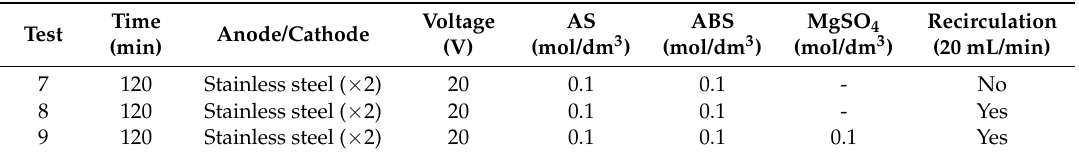
Table 4. Summary of the variation in experimental start parameters for tests with double anode and cathode cell distance.